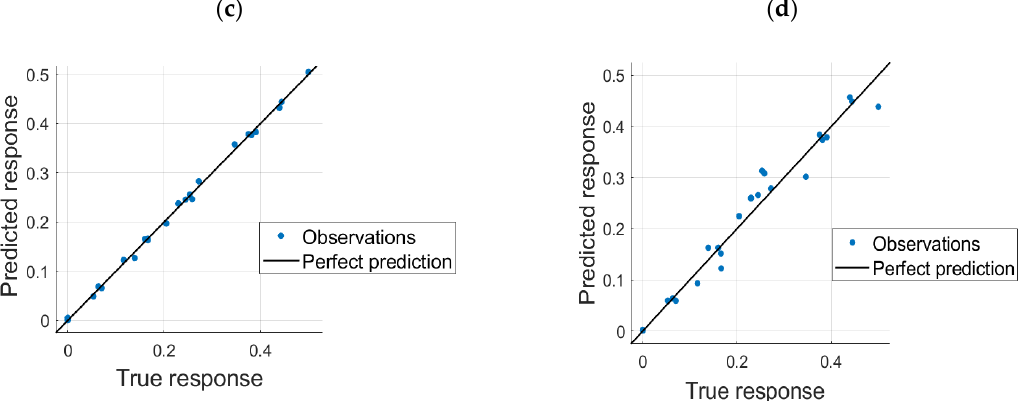
Figure 8. Multi-comparison performances scatter plots of the predicted and actual values for different types of regression learner optimizable models: ( a ) prediction (Optimizable SVM), ( b ) prediction (Optimizable Tree), ( c ) prediction (Optimizable Gaussian Process Regression Model (GPR)) and ( d ) prediction (Optimizable Ensemble).